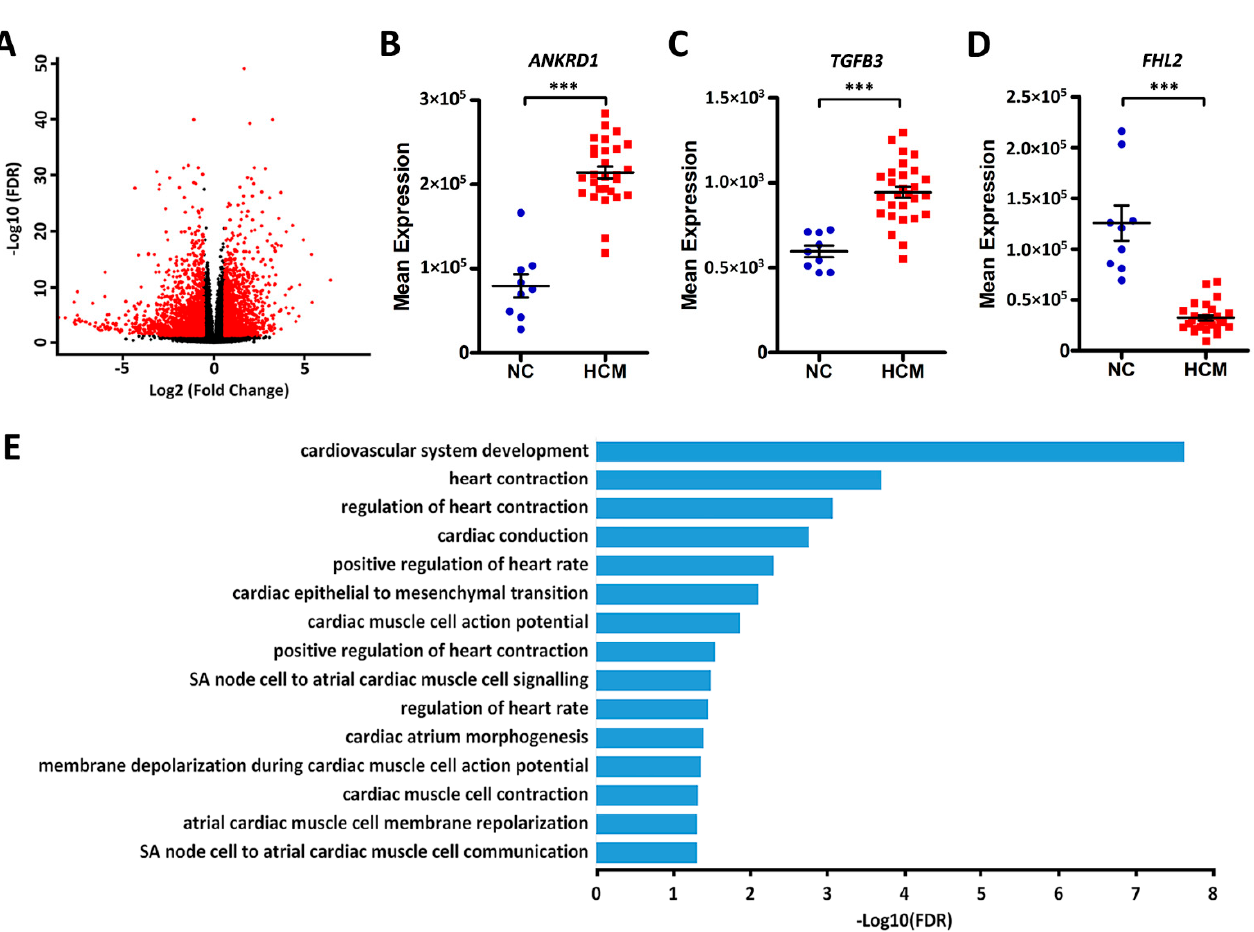
Figure 3. Di ff erentially expressed protein-coding genes between HCM patients and normal controls. ( A ) Volcano plot of the di ff erentially expressed genes (DEGs). The x -axes show the log2 transformed fold change, and the y -axes show the log10 transformed false discovery rate (FDR). Red dots are DEGs with an FDR < 0.05 and fold change > 1.5. ( B–D ) Dot plots of the expression levels of ANKRD1 , TGFB3 , and FHL2 in normal controls (NC) and HCM patients, ***FDR < 0.001. ( E ) Bar plots of the significantly enriched cardiovascular-related Gene Ontology (GO) terms for the di ff erentially expressed protein-coding genes.